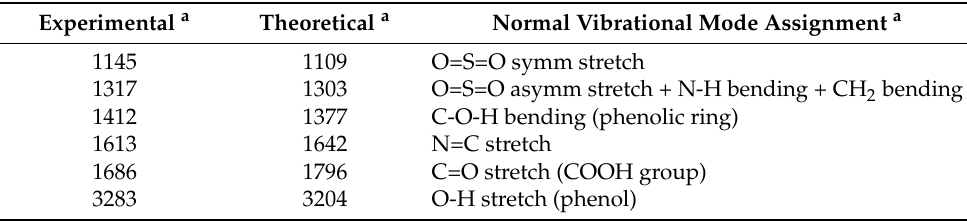
Table 3. Experimental and theoretical vibrational frequencies (cm − 1 ) of H 3